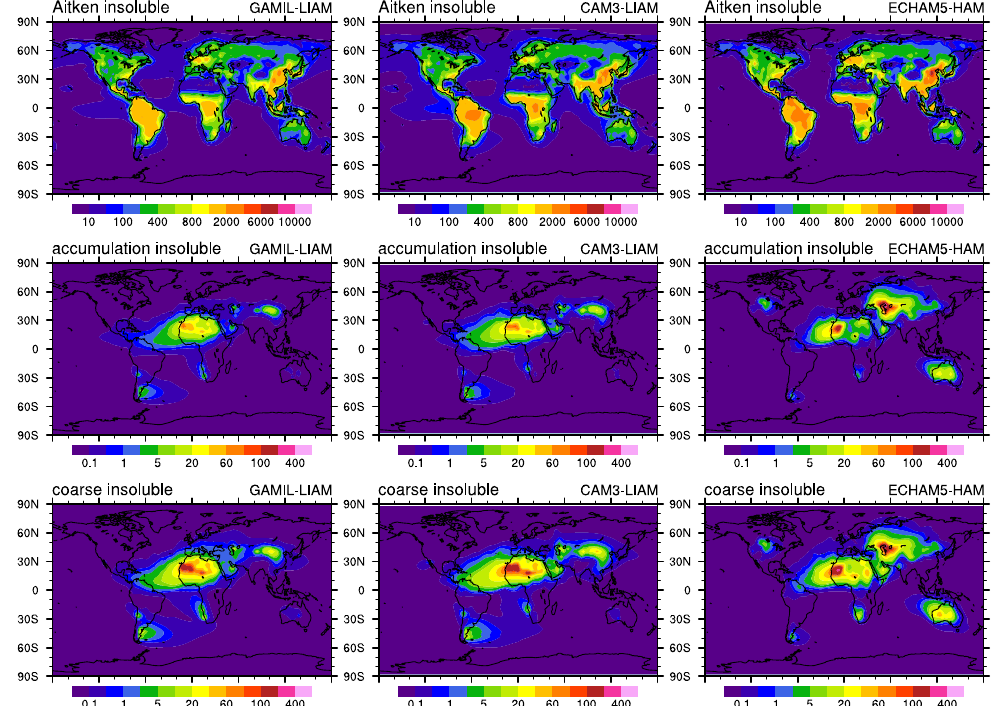
Fig. 7. Annual mean aerosol number concentration of the three insoluble modes (from top to bottom) at the lowest model level simulated by GAMIL-LIAM (left column), CAM3-LIAM (middle column) and ECHAM5-HAM (right column). The unit is number of particles per cubic centimeter at the standard atmospheric state (1013.25hPa,